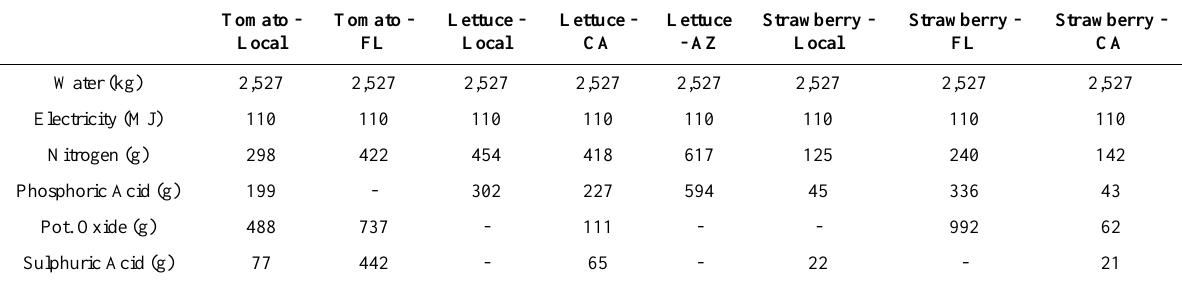
Table 1. Inputs for crop production